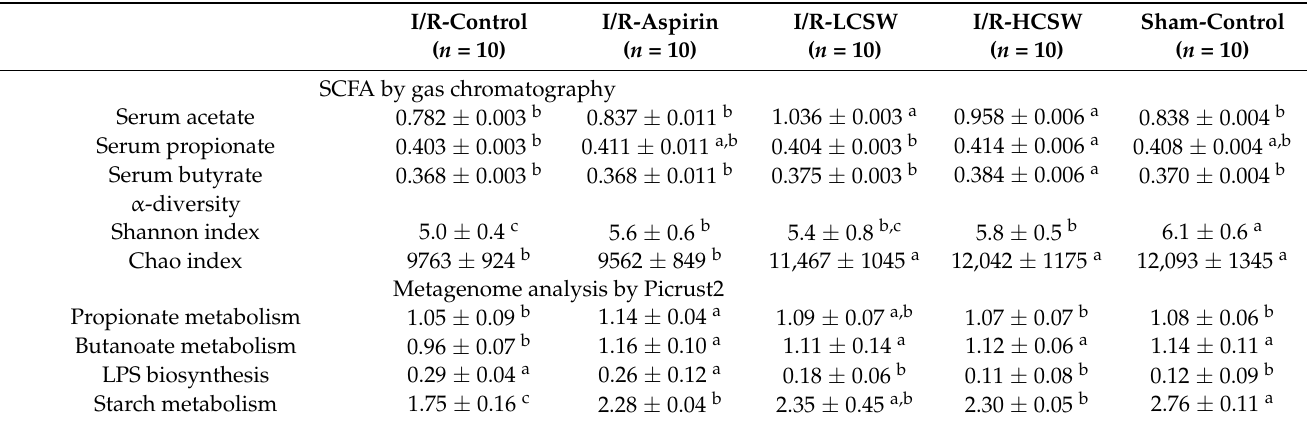
Table 5. Serum short-chain fatty acid (SCFA) concentrations, α -diversity, and metagenome analysis.